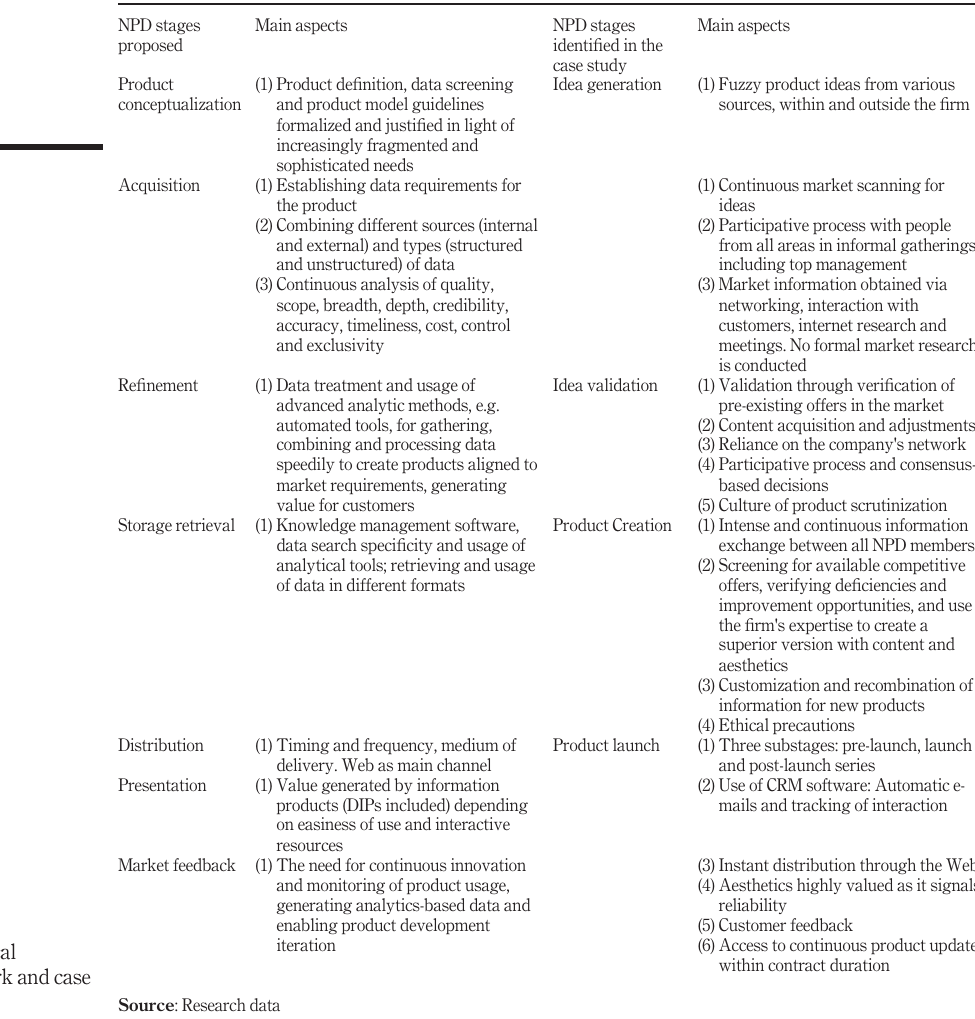
framework and case